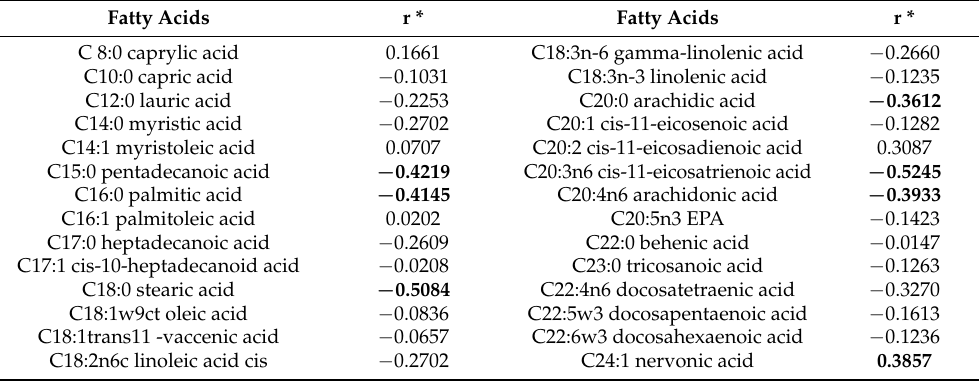
Table 2. Correlations between the amount of potassium in red blood cells and fatty acids in women with PCOS.